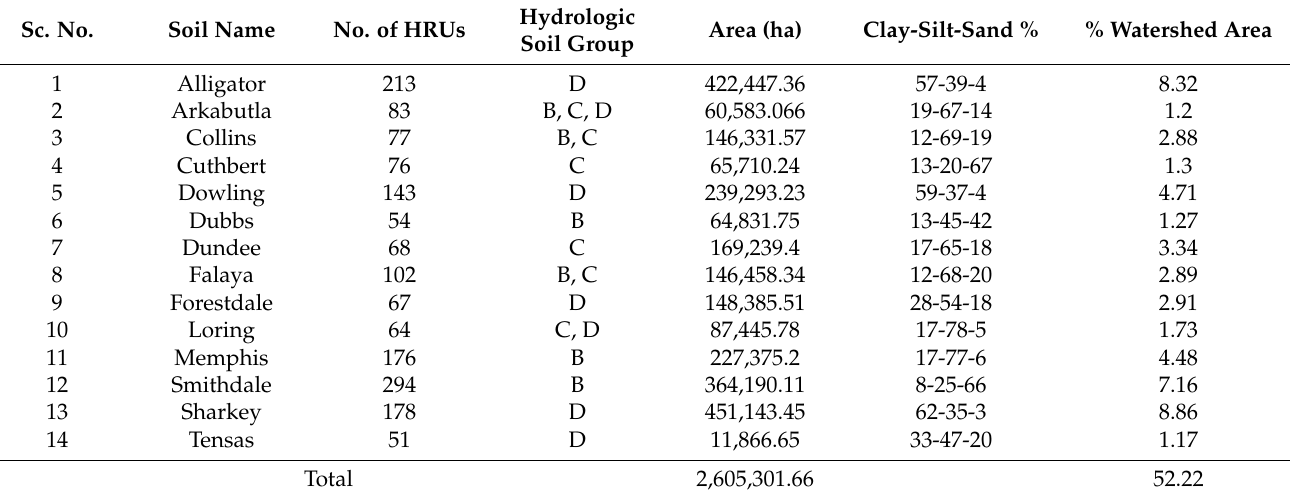
Table 1. List of predominant soils based on area coverage and clay silt sand